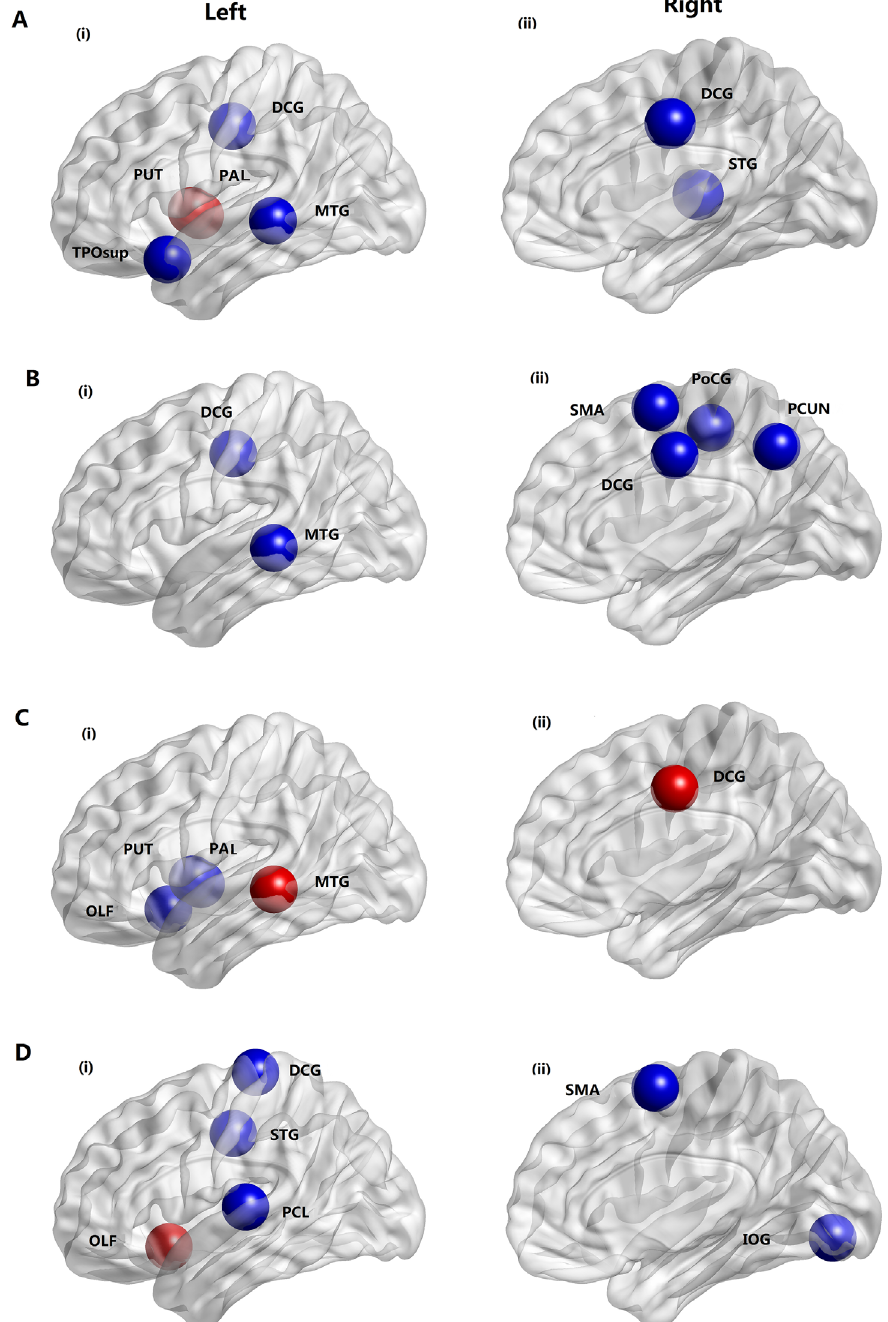
Fig 2. Distribution of brain regions in which small-world properties decreased(blue) or increased(red) significantly in SVCI patients compared to the healthy controls over a wide range of correlation thresholds (0.05 < T < 0.4). (A) global efficiency; (B) clustering coefficient; (C) characteristic path length; (D) local efficiency; DCG = median cingulate and paracingulate gyri; MTG = middle temporal gyrus; PUT = putamen; PAL = pallidum; TPOsup = temporalpole: superior temporal gyrus; STG = superior temporal gyrus; SMA = supplementary motor area; PCUN = Precuneus; PoCG = postcentral gyrus; OLF = Olfactory cortex; PCL = paracentral lobule; IOG = Inferior occipital gyrus